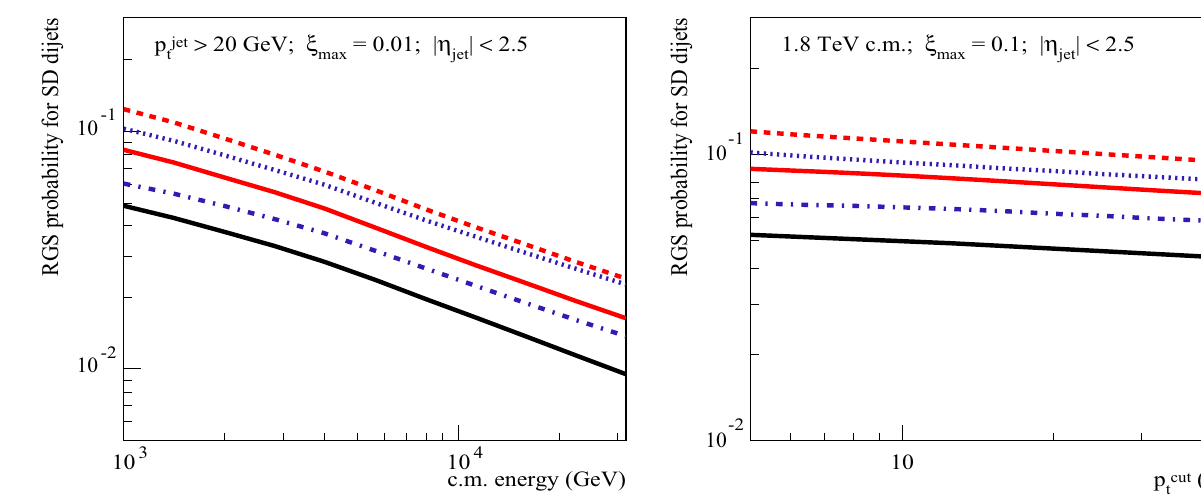
calculated with the default SD ( tot )